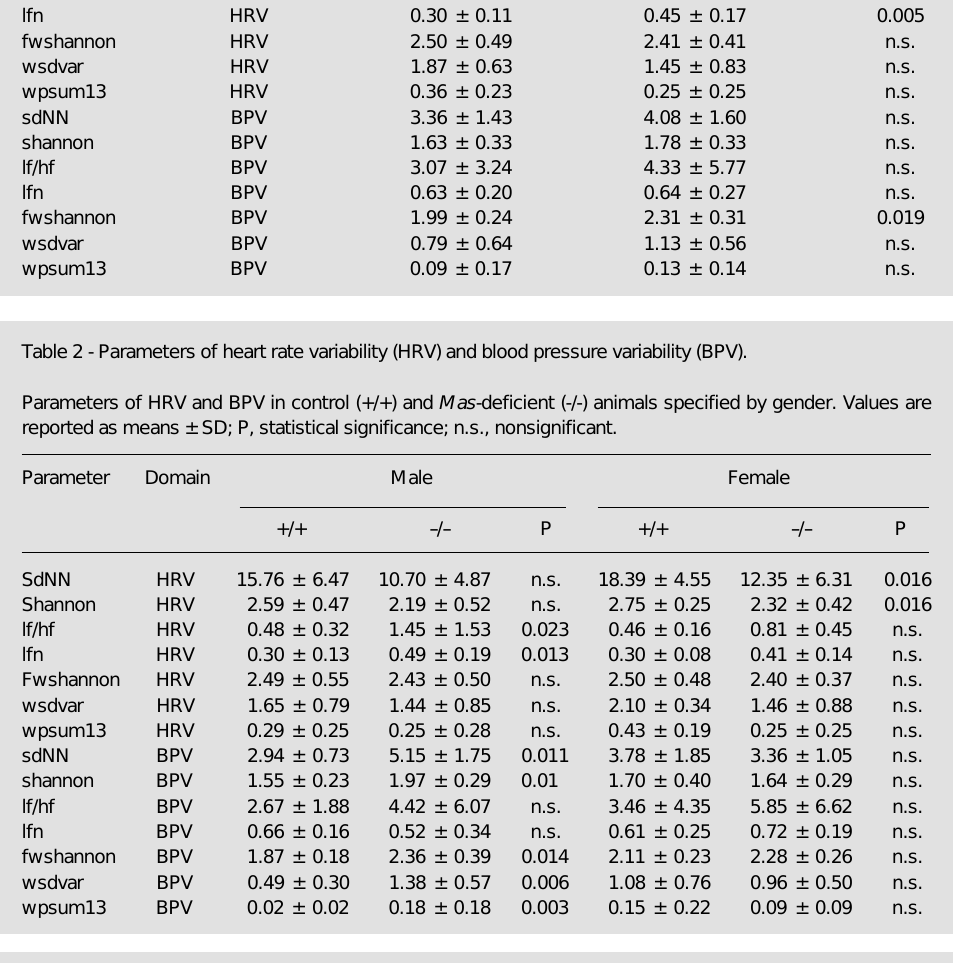
Table 3 - Spontaneous